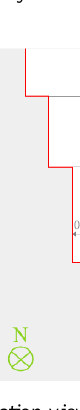
Figure 5. North direction view of the synthetic wall with its dimensions (red line as vertical section)